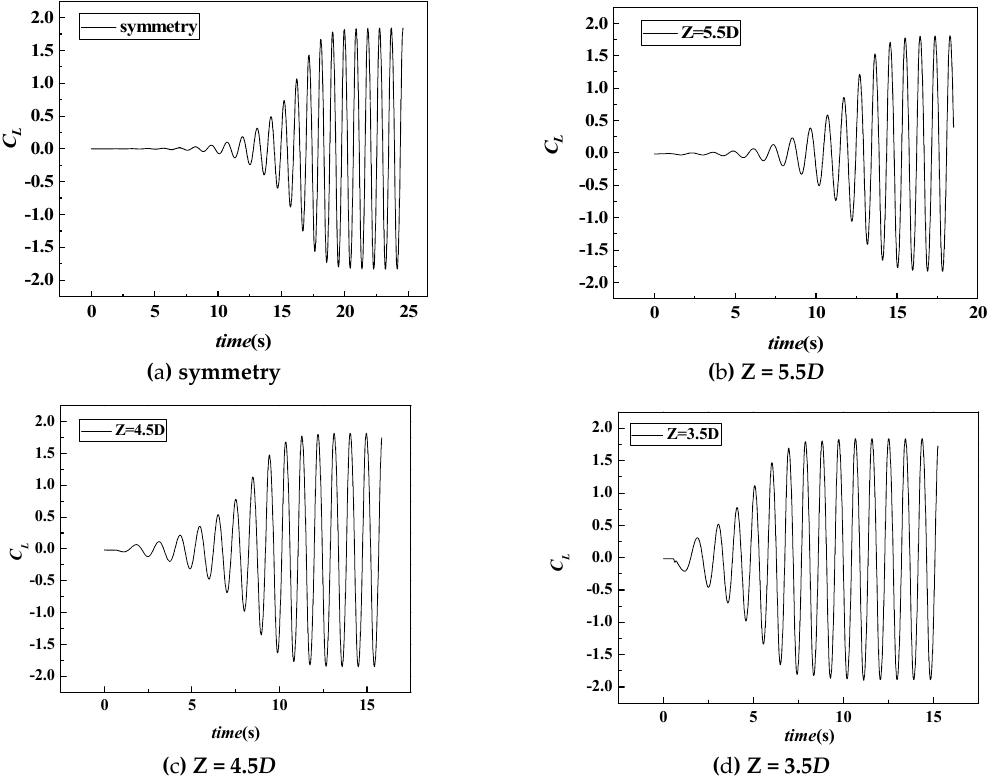
Figure 4. Time history of C L of the stationary cylinder at different free surface heights Z ( Re = 3.5 × 10 4 ).